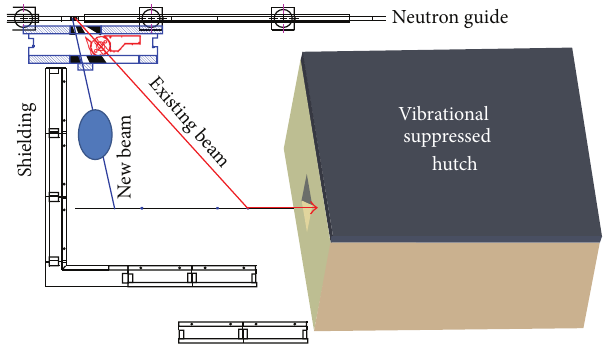
Figure 6: Schematic of the existing beam line setup with the hutch and a new beam line for the DFS interferometer.